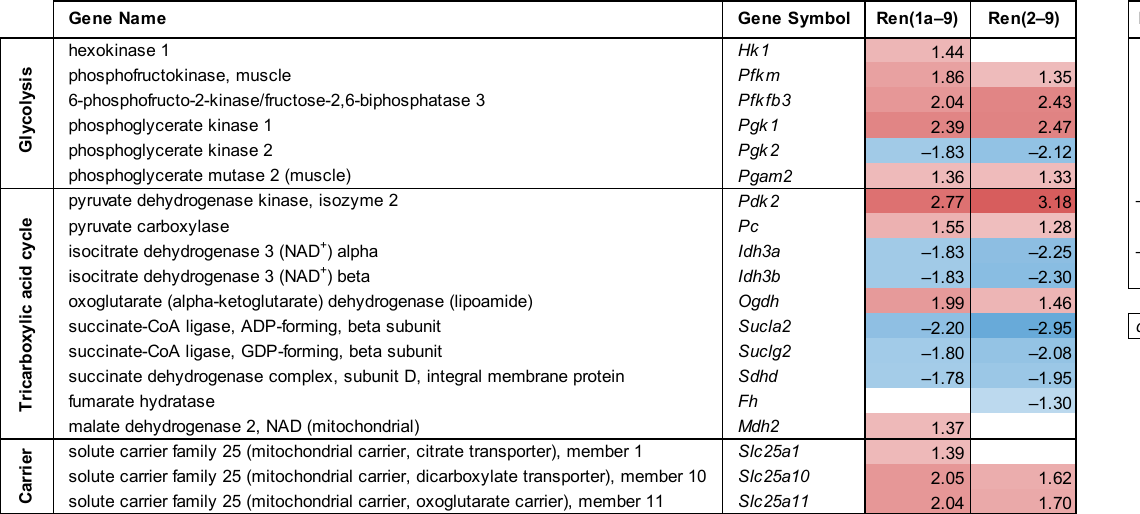
Figure 2. Alterations in the expression of genes involved in glycolysis, the tricarboxylic acid (TCA) cycle, and mitochondrial transport. The transcript levels were identified by microarray analyses as a result of either Ren(1a–9) or Ren(2–9) overexpression as compared with pIRES H9c2 control cells. The red color indicates genes with increased and the blue color indicates those with decreased while the transcript levels of several TCA cycle-related enzymes were reduced. mRNA levels as compared with pIRES controls, while the white color indicates genes that were not significantly altered with q > 0.05. Shown are only significantly altered genes ( q < 0.05) that exhibit a fold change ≥ |1.3| in at least one group comparison.